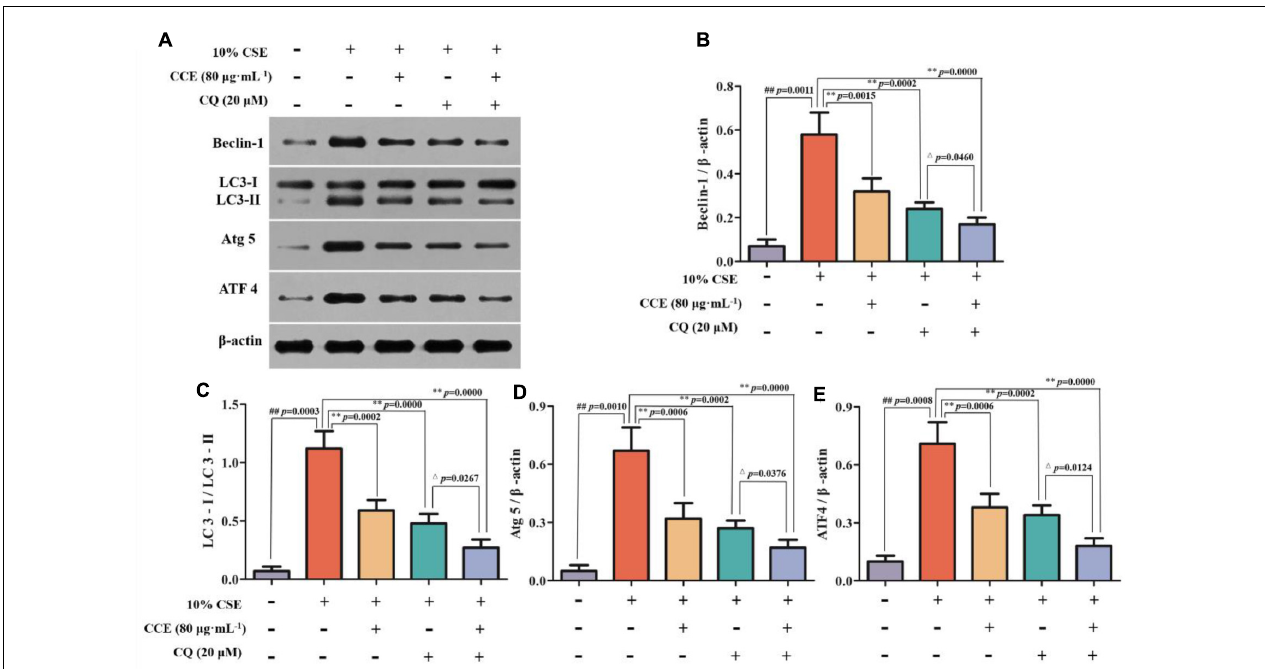
FIGURE 7 | Regulation of CCE on autophagic proteins in the presence of autophagy inhibitor CQ. Cells were treated with 20 mM CQ with or without 80 mg mL − 1 CCE (A) . Autophagic proteins including Beclin-1 (B) , LC3-II/LC3-I ratio (C) , Atg5 (D) and ATF4 (E) were detected by Western blotting analysis. Data are expressed as means ± SD ( n = 3). ## p < 0.01, vs. the blank control; ∗∗ p < 0.01, vs. 10% CSE; (cid:52) p < 0.05, ∗∗ p < 0.01, vs. 20 µ M CQ.